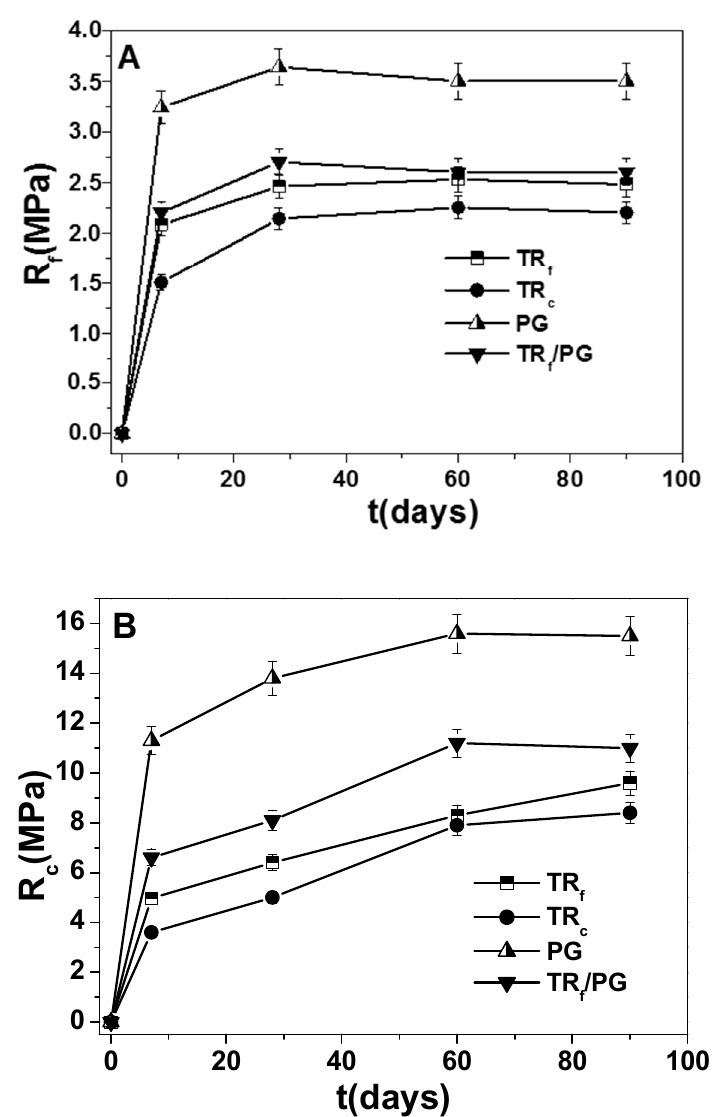
Figure 7. Temporal evolution of the ( A ) flexural and ( B ) compressive resistances of sample 3 (TR f ), sample 4 (TR c ), sample 5 (PG) and sample 8 (TR f /PG).